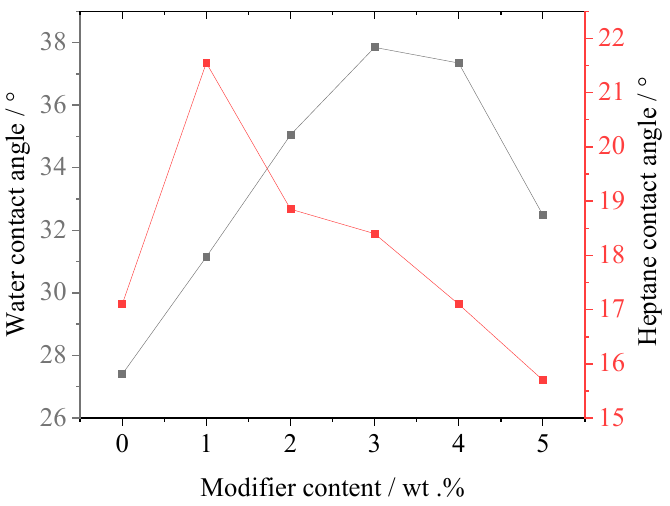
Figure 10. The contact angles of n-heptane, water on calcined kaolin surface change as modifier content.